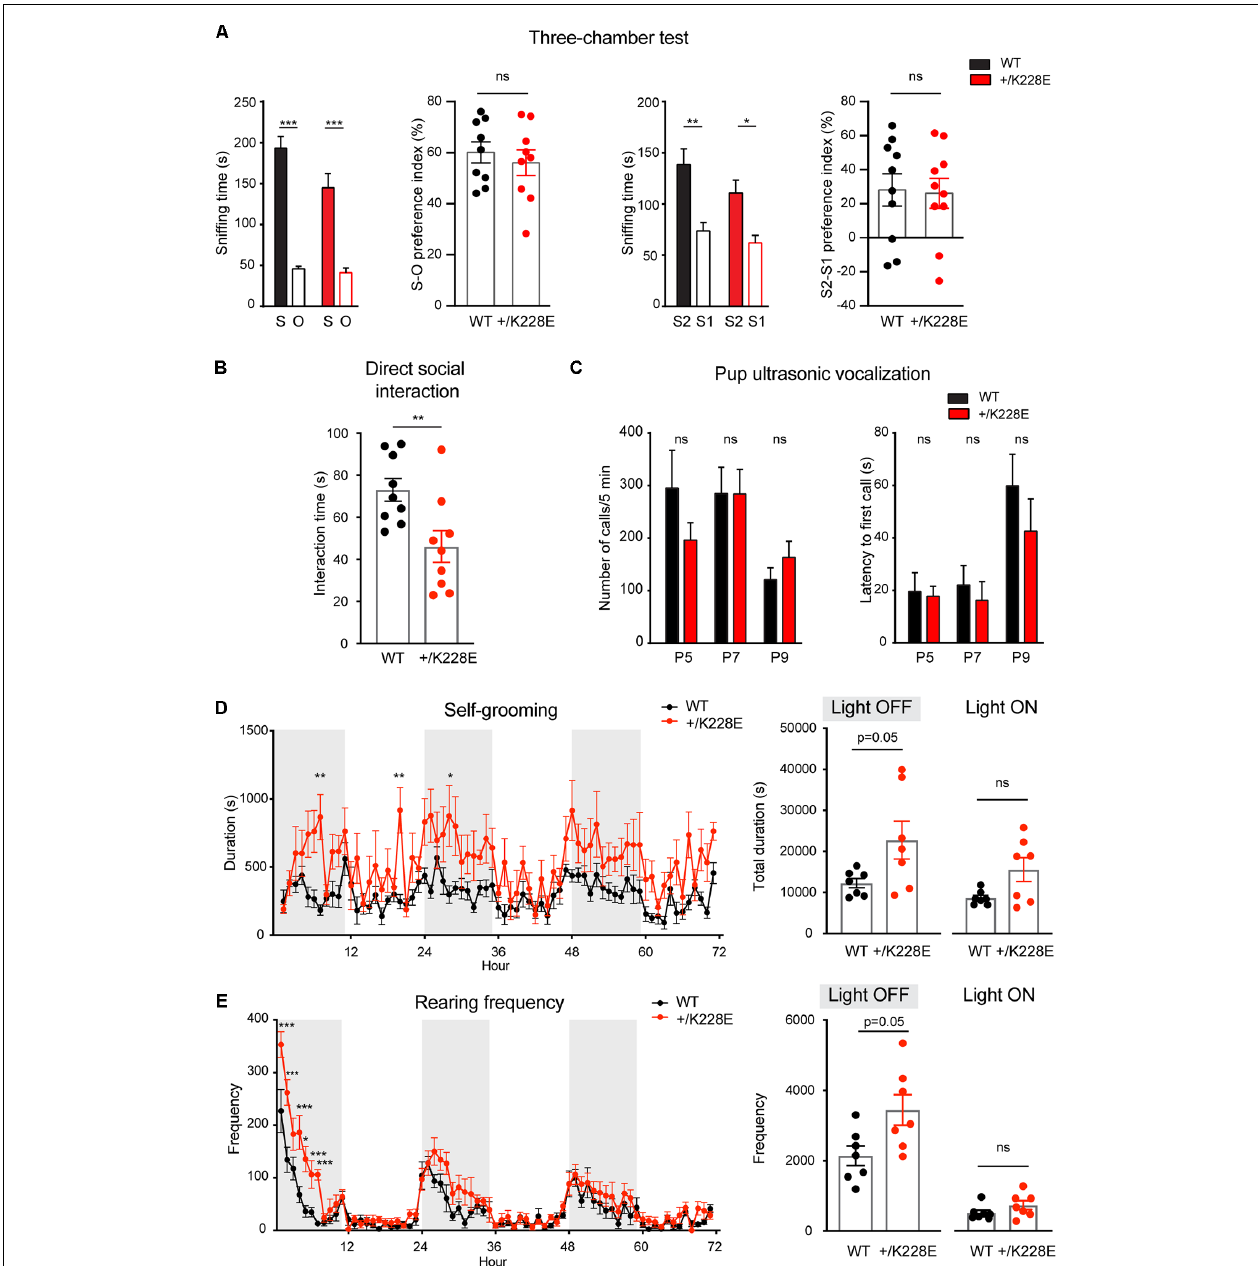
FIGURE 7 | Social deficits and repetitive behaviors in Tbr1 + / K228E mice. (A) Normal levels of social approach and social novelty recognition in Tbr1 + / K228E mice (3 months; male) in the three-chamber test, as shown by time spent exploring social (S1) vs. object (O) targets for social approach, or old stranger (S1) vs. new stranger (S2) for social novelty, and the social preference index [i.e., (time spent in sniffing S1 − time spent in O)/total time spent (S1+O) × 100]. n = 9 mouse pairs for WT and HT (social approach), n = 10 mouse pairs for WT and HT (social novelty), ∗∗∗ P < 0.001, two-way ANOVA with Sidak’s test (for S-O or S2-S1 comparisons; multiple comparisons between S-S, S1-S1, or S2-S2 were not performed for the lack of genotype × target interactions), ns: not significant, Student’s t -test (preference index). (B) Suppressed direct social interaction in Tbr1 + / K228E mice (3 months; male), as indicated by time spent in total interaction between age-, sex- and genotype-matched mouse pairs. n = 9 mouse pairs for WT and HT, ∗∗ P < 0.01, ns: not significant, Mann–Whitney test. (C) Normal ultrasonic vocalizations (USVs) in Tbr1 + / K228E pups (P5–9; male and female) separated from their mothers, as indicated by the number of emitted USVs and latency to first USV call. n = 12 pups (WT-P5), 9 (HT-P5), 15 (WT-P7), 16 (HT-P7), 15 (WT-P9) and 16 (HT-P9; number of calls), n = 12 (WT-P5), 9 (HT-P5), 15 (WT-P7), 15 (HT-P7), 15 (WT-P9) and 16 (HT-P9; latency to first call), ns, not significant, two-way ANOVA with Sidak’s multiple comparisons test. (D,E) Enhanced self-grooming and rearing in Tbr1 + / K228E mice (3 months; male) in Laboras cages, where mouse movements were monitored for 72 consecutive hours without prior habituation. n = 7 mice for WT and HT, ∗ P < 0.05, ∗∗∗ P < 0.001, ns: not significant, two-way repeated-measures ANOVA with Sidak’s multiple comparison test and Mann–Whitney test